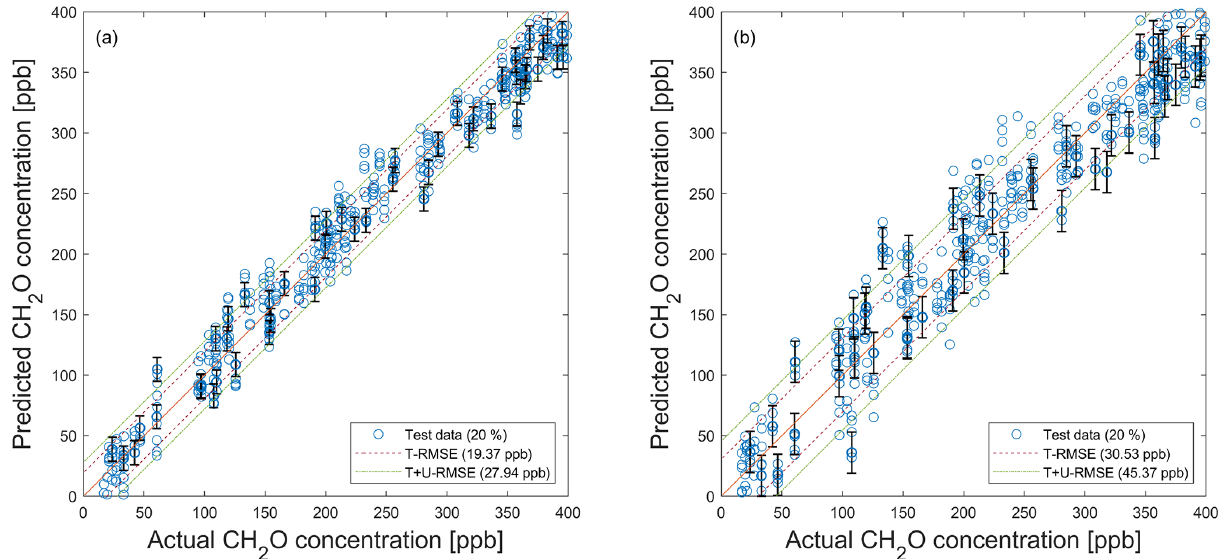
Figure A2. PLSR model (trained with noisy data; n comp = 20) applied to noisy test data (see Fig. 5) for the quantification of formalde- hyde using their associated standard uncertainty. (a) SNR = 55dB. (b) SNR = 40dB. Dashed red and green lines indicate the test RMSE (T − RMSE) and the test plus uncertainty RMSE (T + U − RMSE) based on test data, respectively. For better visibility, error bars are only shown for every 10th